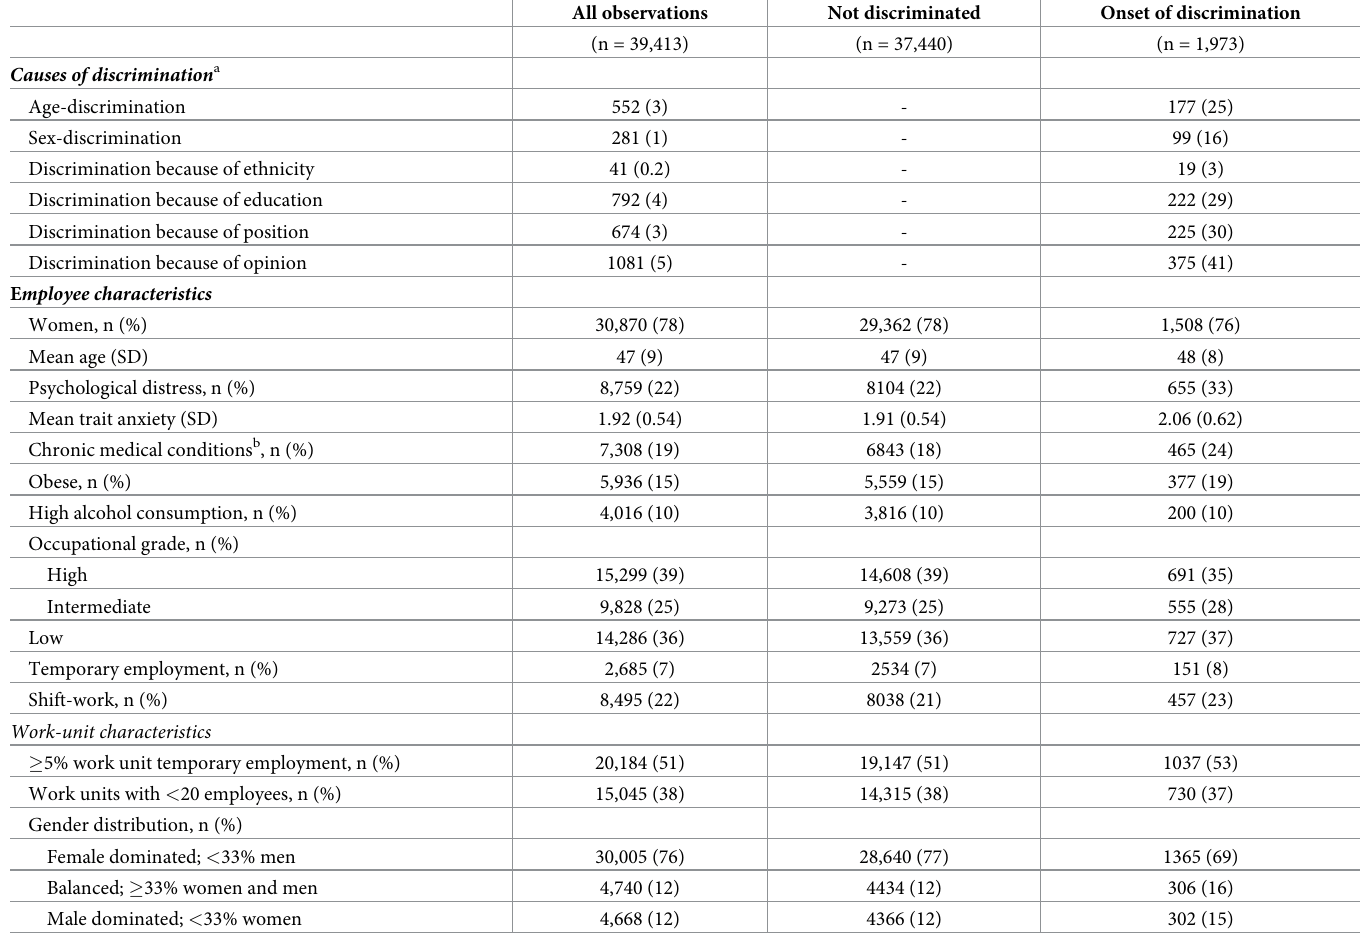
Table 1. Baseline characteristics of the Finnish Public Sector Study sample (in the onset analysis). All observations Not discriminated Onset of discrimination (n = 39,413) (n = 37,440) (n =